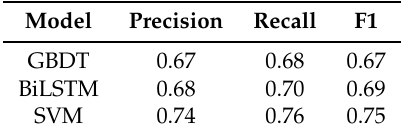
Table 4. Intent category classification results for user